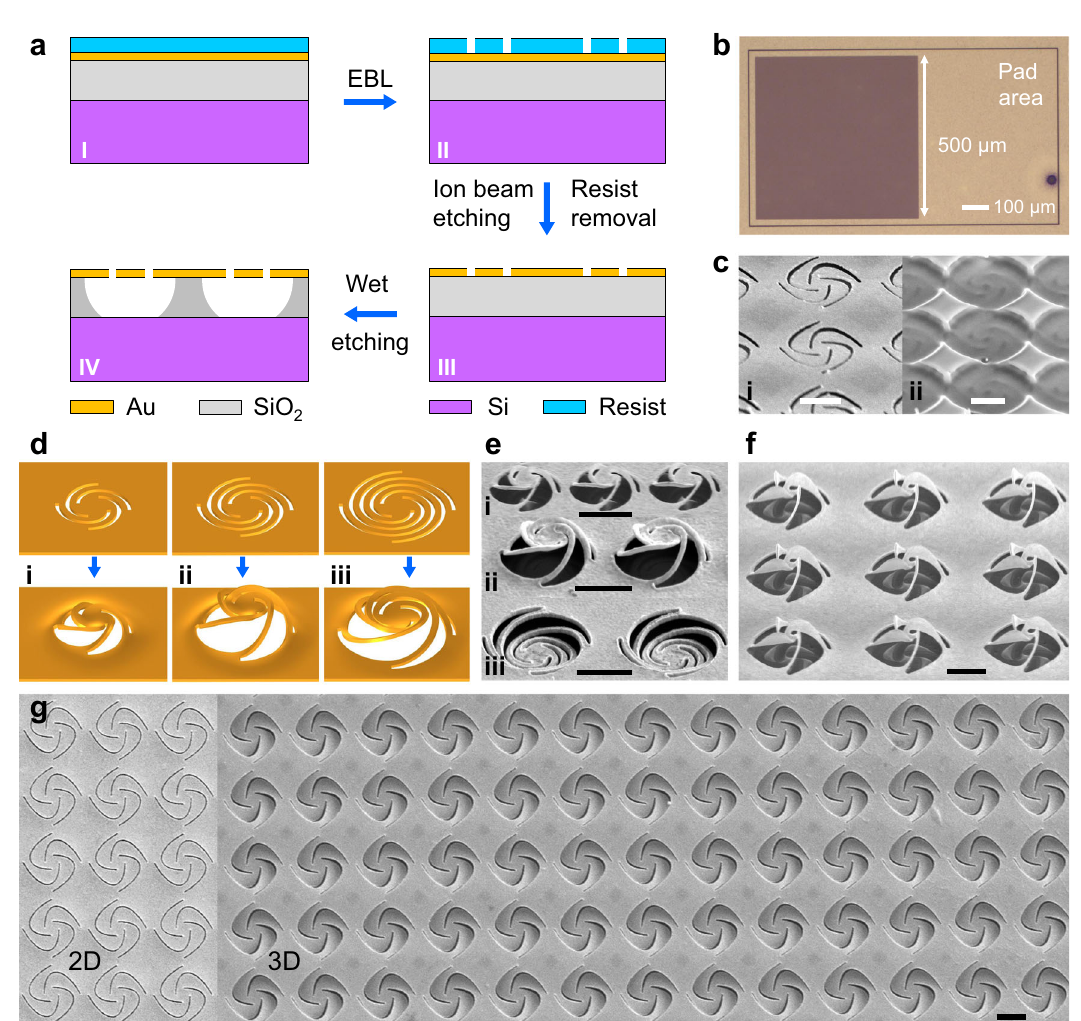
500 nm in g . Scale bars: 1 µ